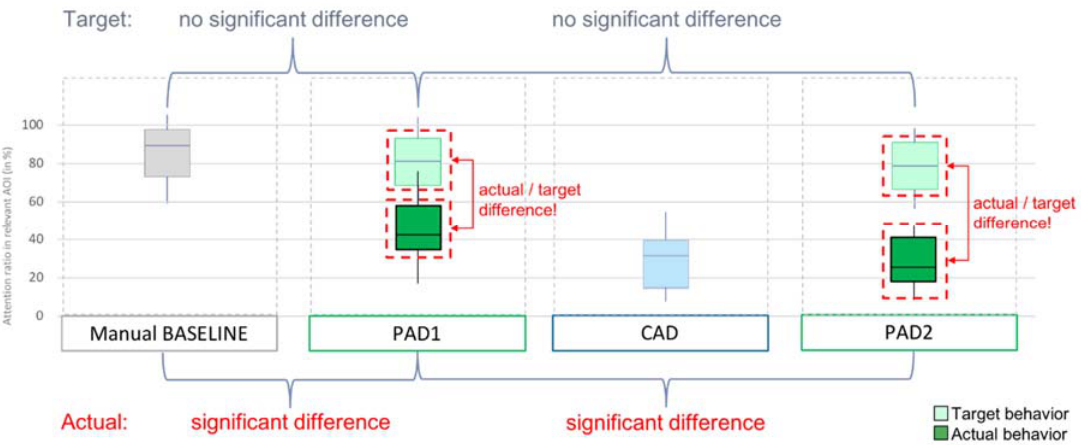
Figure 3. A schematic depiction of the target and actual gaze behavior during manual, PAD and CAD driving. Mode awareness can be assumed if there is no significant difference between the attention ratio in the manual and the first PAD drive or a significant decline in monitoring behavior from the first to the second PAD drive.